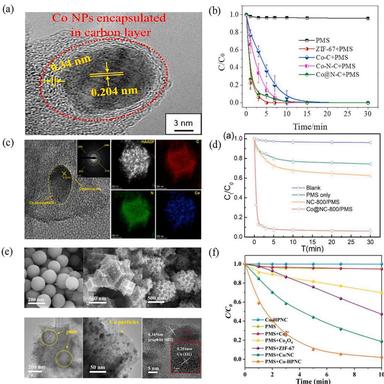
Performance of M@C prepared by different derivatization methods. (a) HRTEM images of Co@N–C, and (b) BPA removal. Copyright 2018 Elsevier. (c) HAADF-TEM image of Co@NC-800 and corresponding elemental mappings of C, N and Co elements, and (d) TC removal efficiency . Copyright 2020 Elsevier. (e) SEM images of SiO2, Co/NC and Co-HPNC, TEM images, HRTEM images, and (f) AO7 removal efficiency. Copyright 2022 Elsevier.